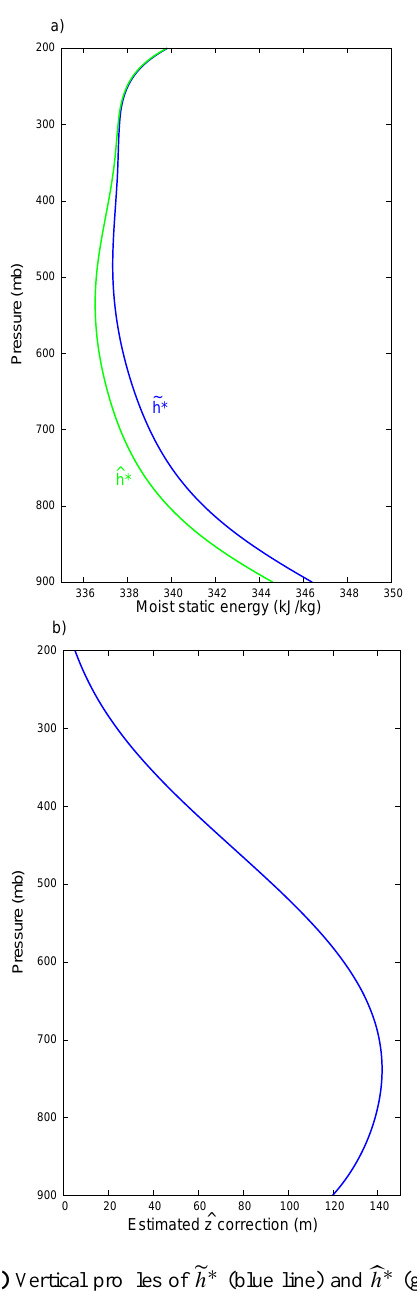
Fig. 2. (a) Vertical profiles of e h ∗ (blue line) and b h ∗ (green line; Eq. 11) for the Jordan (1958) sounding. (b) Error in the calculation of b z , as discussed in the main text and estimated from Eq.